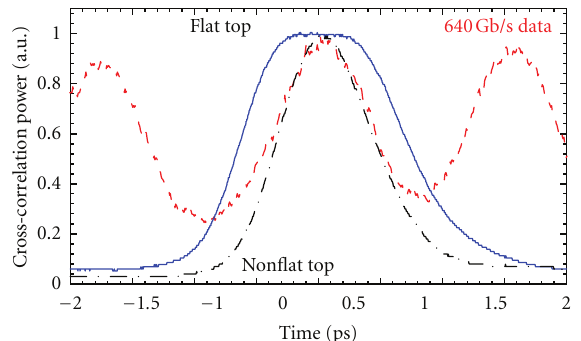
Figure 10: Cross-correlation of the data (dashed), flat-top (solid), and nonflat-top (dash-dot) gating pulses.